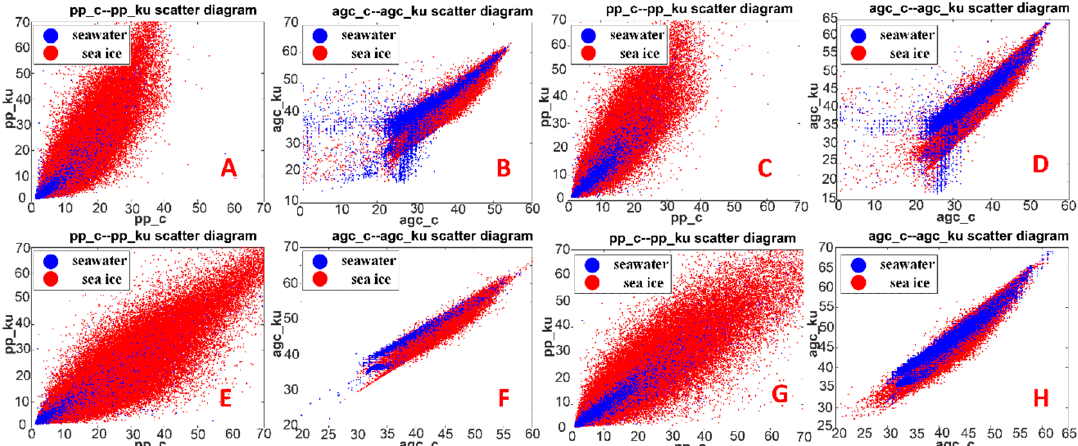
Figure 15. Scatter plots of the Automatic Gain Control (AGC) and Pulse Peaking (PP) values: Figure 15A–D used the data of the HY-2A ALT; Figure 15E–H used the data of the HY-2B ALT; Figure 15A,B,E,F are the scatter plots of the Arctic regions; Figure 15C,D,G,H are the scatter plots of the Antarctic regions.